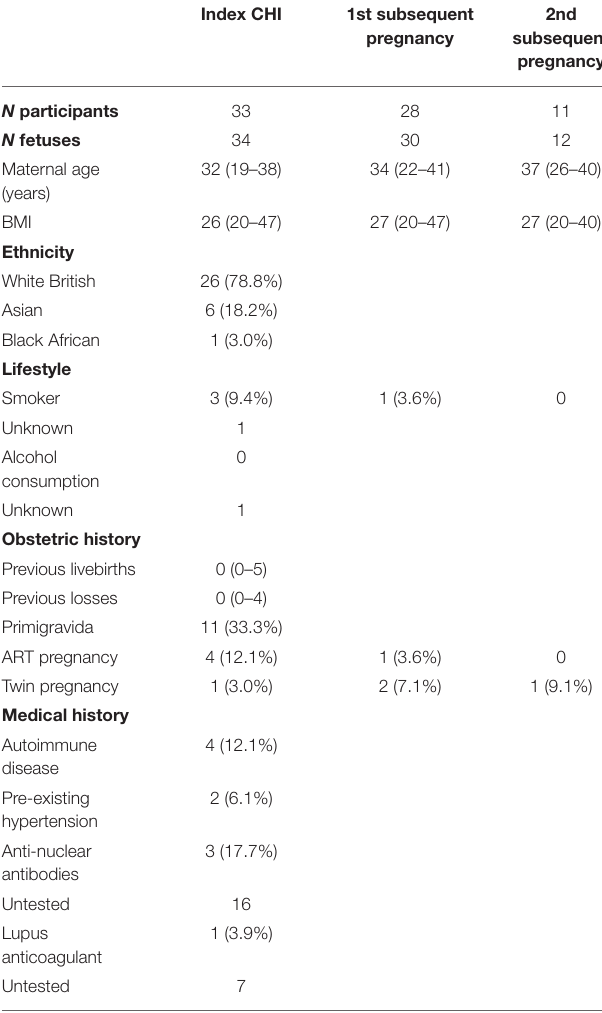
TABLE 1 | Demographics and obstetric and medical history of women with a diagnosis of chronic histiocytic intervillositis